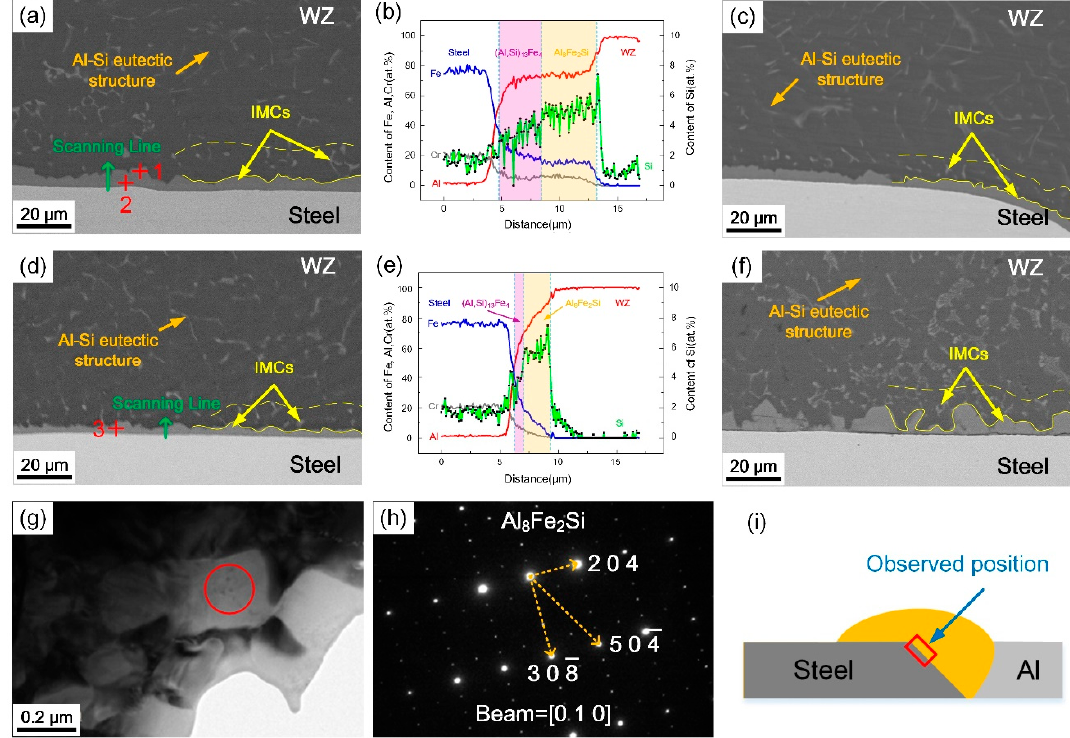
Figure 4. Microstructure, EDS line scanning results and selected area electron diffraction pattern of the WZ)/steel interface at different coil currents: ( a – b ) 0 A, 0 Hz; ( c ) 1 A, 0 Hz; ( d – e ) and ( g – h ) 2 A, 0 Hz; ( f ) 3 A, 0 Hz; ( i ) observed position. Table 3. EDS spot scanning results of zones 1–3 in Figure 4.